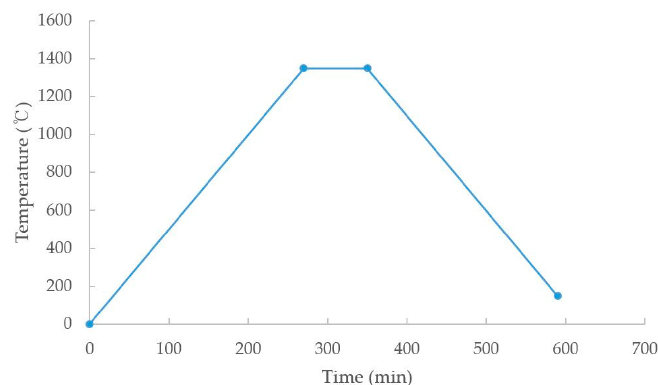
Figure 12. An optimized sintering profile for this study.